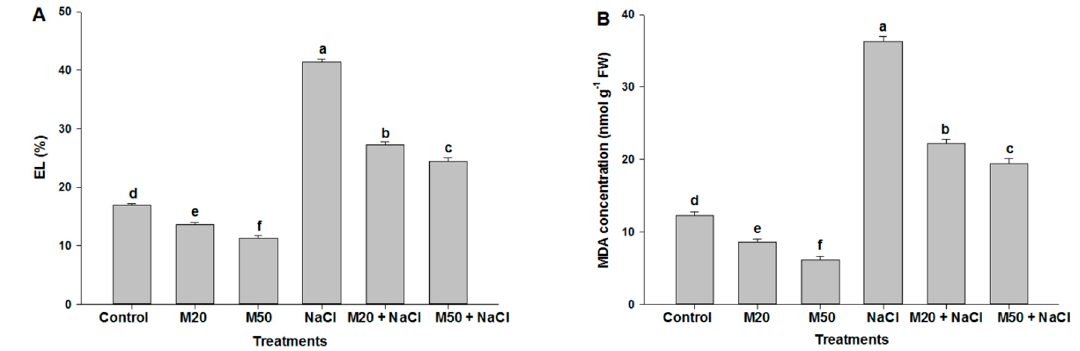
Figure 4. E ff ect of melatonin on ( A ) electrolyte leakage (EL), and ( B ) malondialdehyde (MDA) content in leaves of tomato seedlings under salinity. Data represent mean of 4 replicates with bars indicating SE. The bars labelled with di ff erent letters are significantly di ff erent at p < 0.05%. [DDW (control), 20 µ